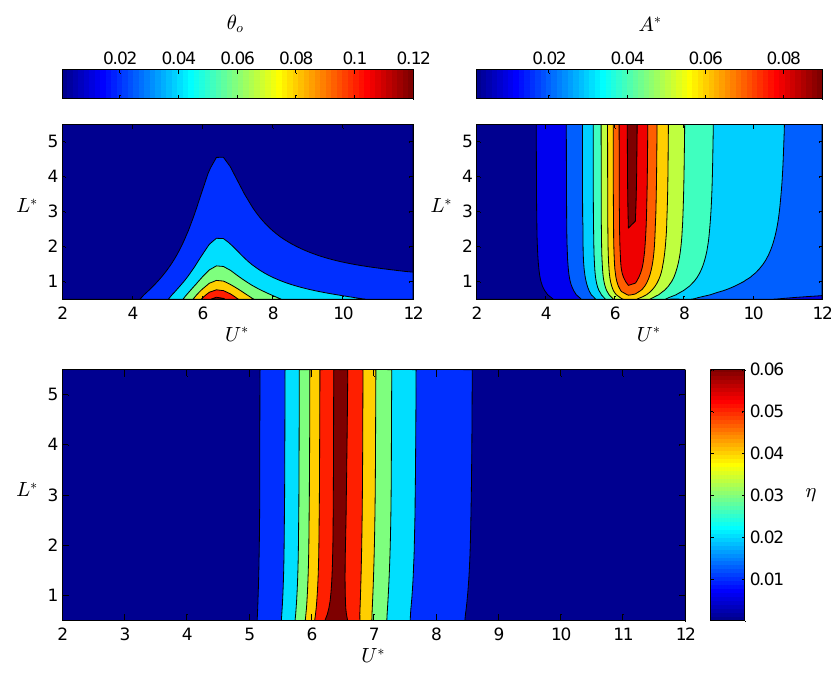
Figure 7. Contours of θ o and η as functions of L ∗ and U ∗ for m ∗ = 50 and ζ =